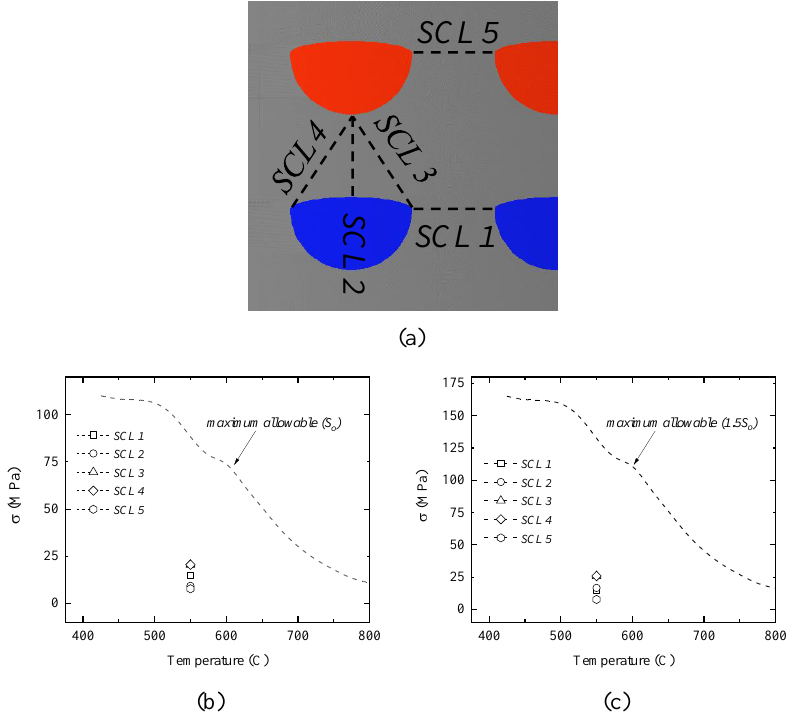
Figure 12. ( a ) Five stress classification lines (SCLs); ( b ) linearization result of membrane stress and compared to So ; and ( c ) the linearization result of membrane + bending stress and compared to 1.5